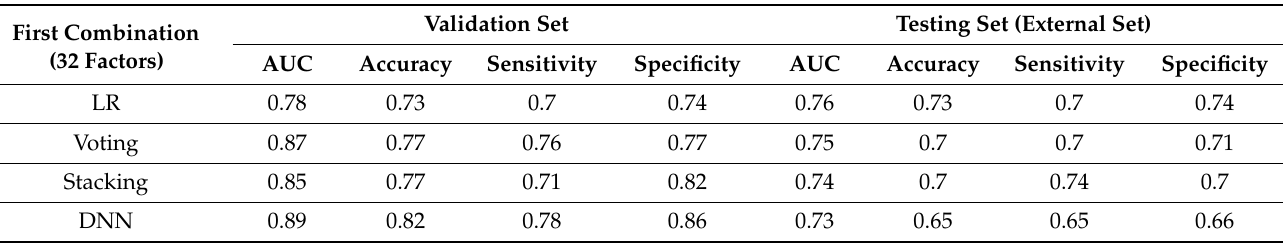
Table 3. Model performance